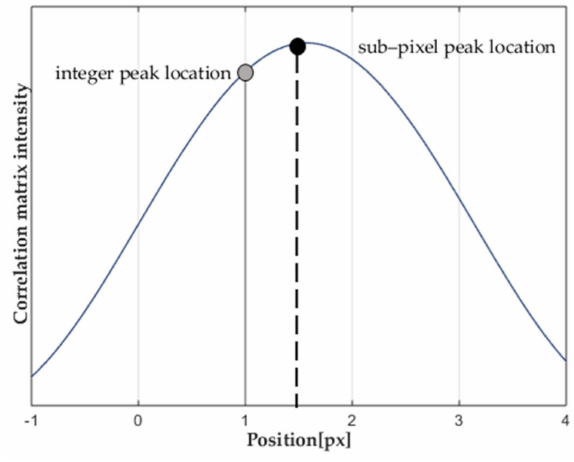
Figure 5. Principle of the Gaussian 2 · 3-point